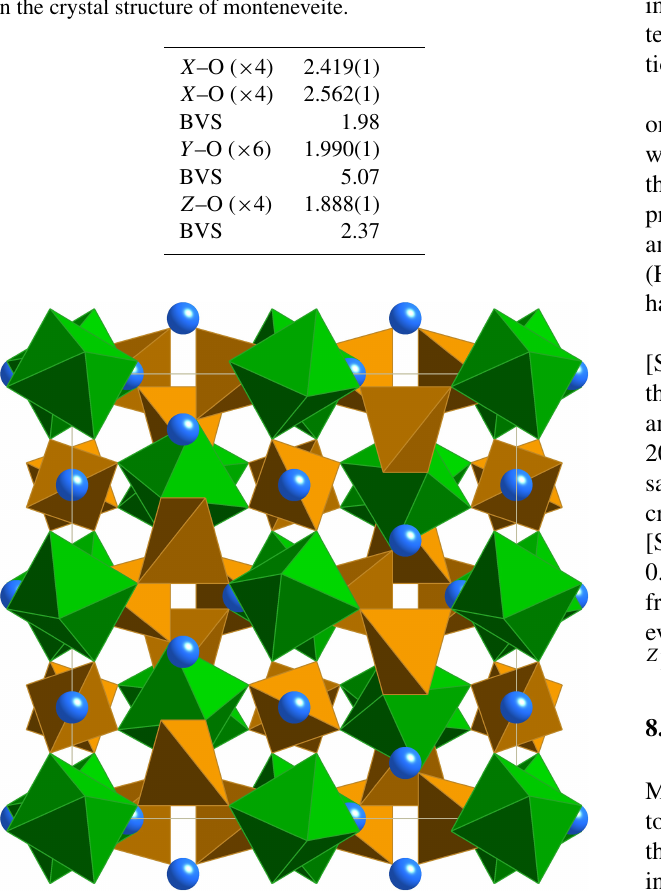
Table 7. Bond distances (Å) and bond valence sums (BVS in v.u.) in the crystal structure of monteneveite.